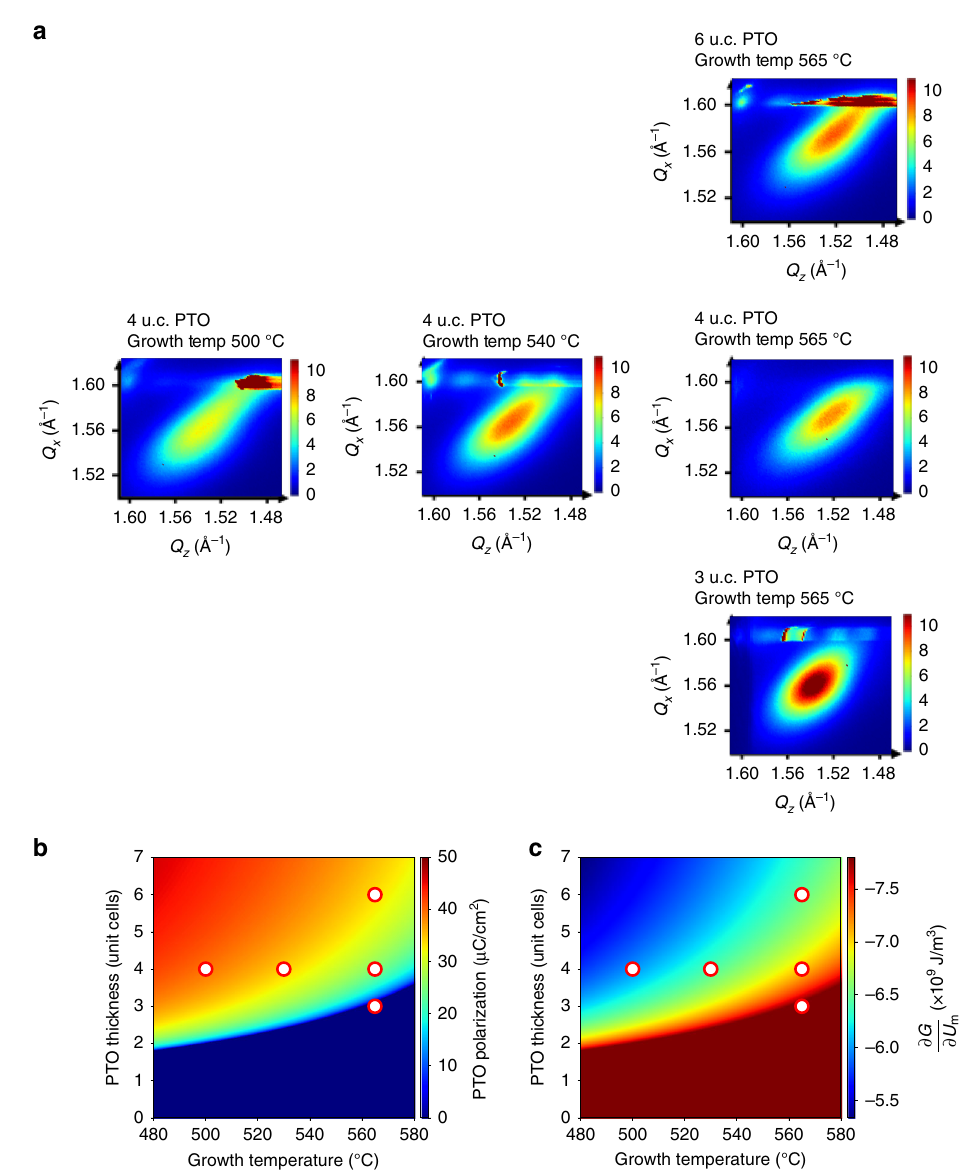
Fig. 5 In situ x-ray diffraction probing strain relaxation. In situ x-ray diffraction probing strain relaxation: a examples of reciprocal space maps obtained by in situ X-ray near (1 0 1) peak: reciprocal space map images around (1 0 1) peak after 10nm BTO is grown on top of different thickness of PTO grown at different temperature. Color scales in these maps correspond to linear intensity in arbitrary units. b Polarization of ultrathin PTO fi lms and c ∂ G ∂ u fi lms calculated via Landau theory plotted against thicknesses and temperatures. The red circles in b and c correspond to the samples in a